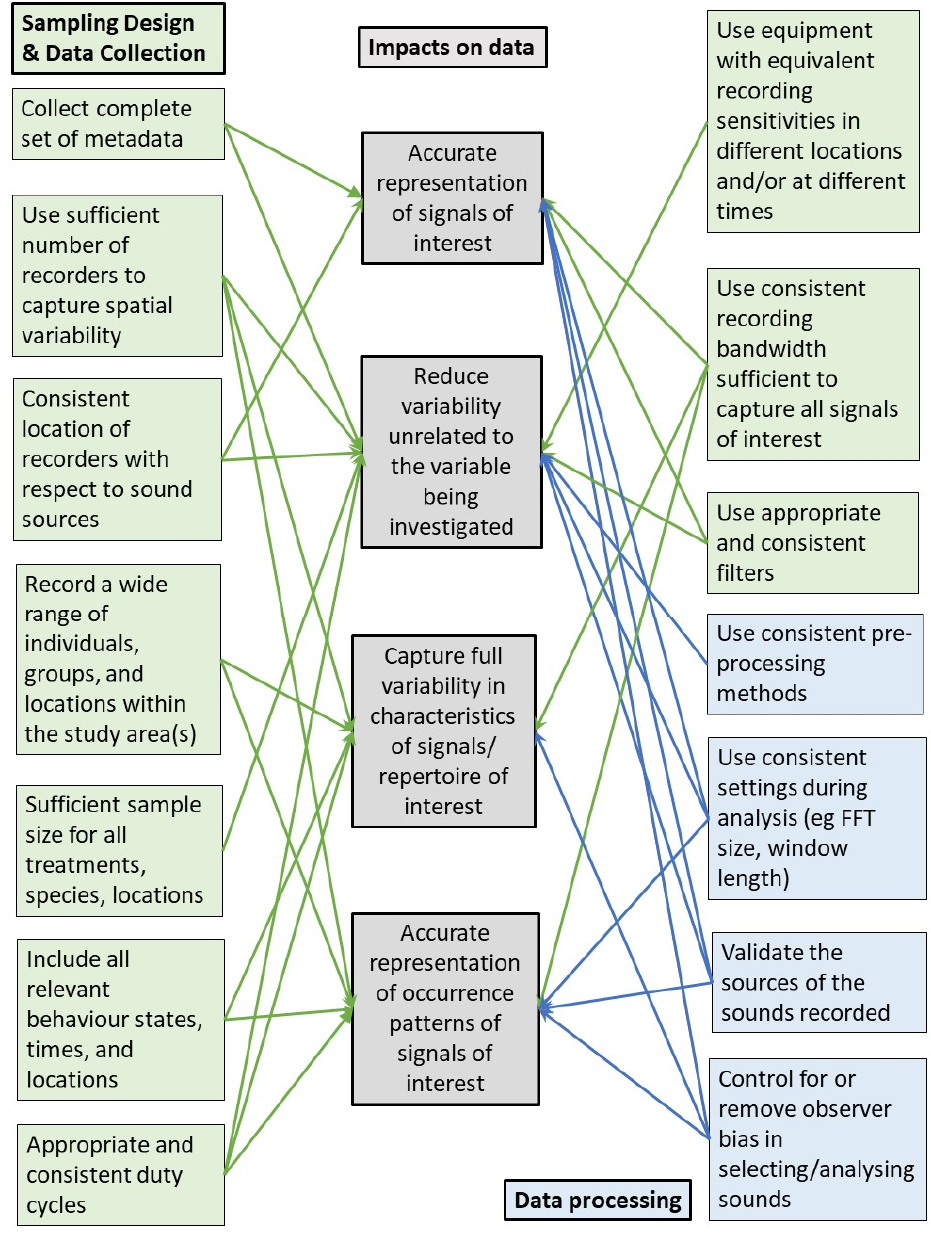
Figure 3. Summary of target best practices in the collection and analysis of bioacoustic data.